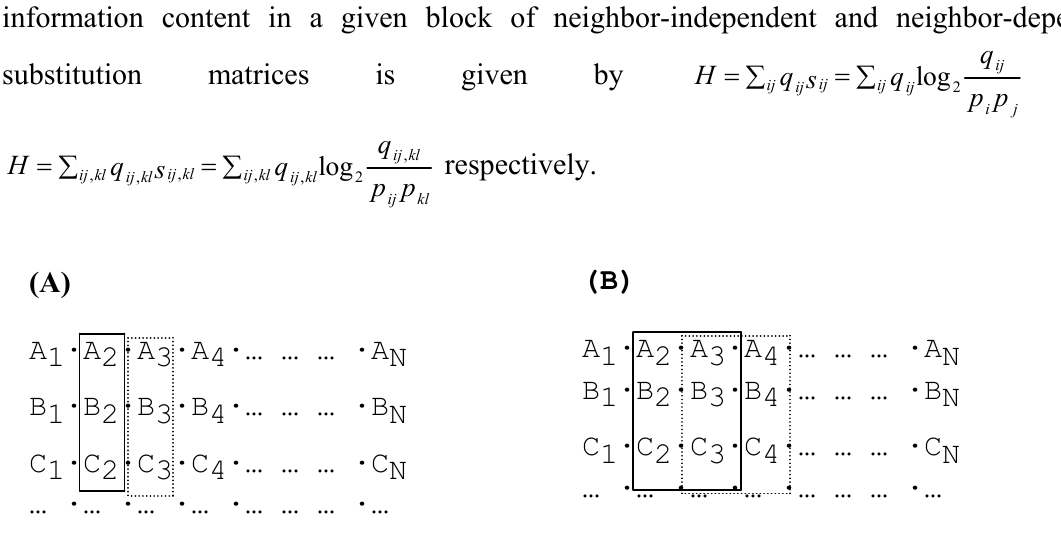
Figure 1: The principle of counting the frequencies illustrated diagrammatically. (A) The left side diagram shows the counting principle for neighbor-independent frequency determination. The three lines show the nucleic acid bases corresponding to the TFBS already aligned in the database. The solid box is used for determination of the actual frequencies and the counts for A2-B2, A2-C2 and B2-C2 are put in a 4×4 matrix. Then the counting box is shifted by one position (dotted box) and the process is repeated. (B) In the right side illustration, we indicate the counting principle for neighbor-dependent (pair-wise) determination of frequencies. In this illustration, we get the actual counts for A2A3-B2B3, A2A3-C2C3, B2B3-C2C3 and these are placed in a 16×16 matrix. The counting box is next moved right by one base position (shown by the dotted box) and the process continued till the TFBS region is completed. See text for the